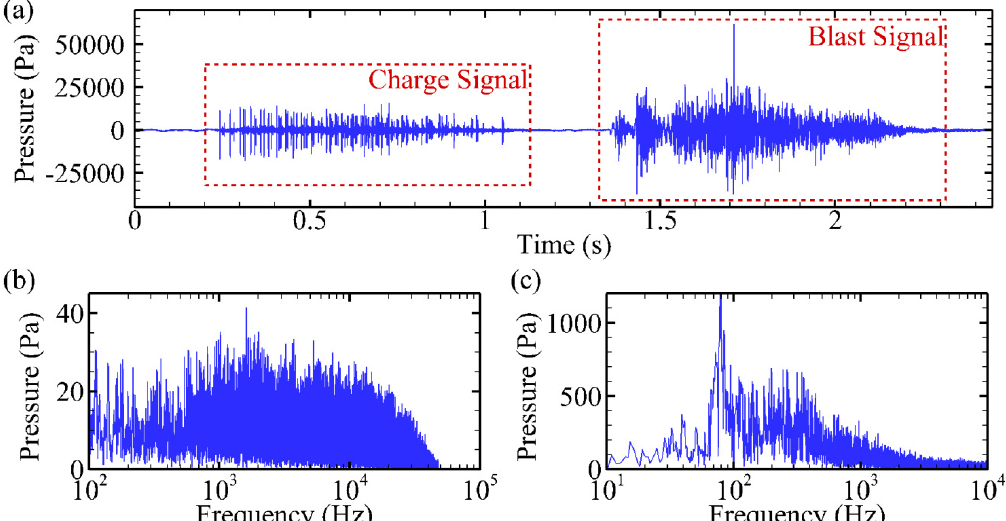
Figure 12. Sample underwater rock blasting measurement. ( a ) Charge and blast signal waveforms; ( b ) charge signal spectrum; ( c ) blast signal